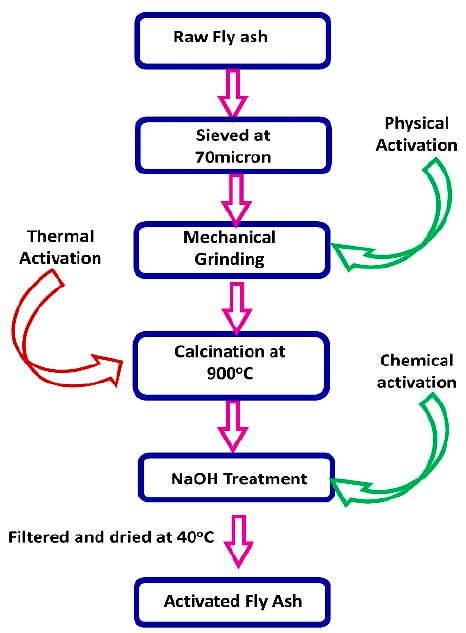
Figure 2. Schematic diagram for fly ash activation process.